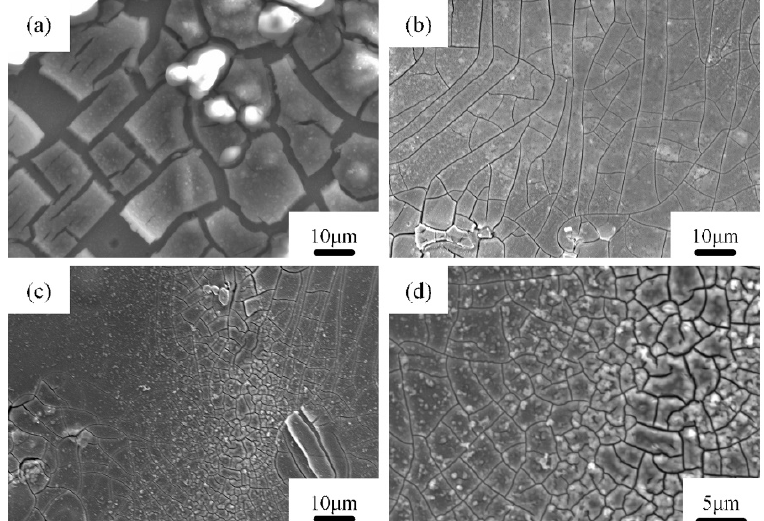
Figure 12. The scanning electron microscopy images of the Al-Zn-Mg-Cu alloy as a function of annealing pressure and after corrosion in 3.5 wt.% NaCl solution: ( a ) sample annealed at atmospheric pressure, ( b ) 2 GPa, and ( c , d ) 3 GPa, respectively.